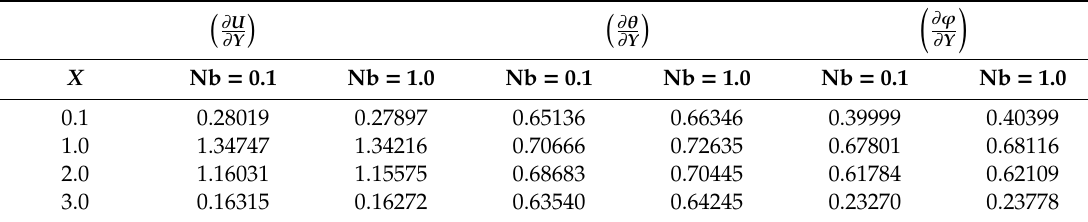
Table 1. Physical e ff ects on quantities ∂ U ∂ are constant.